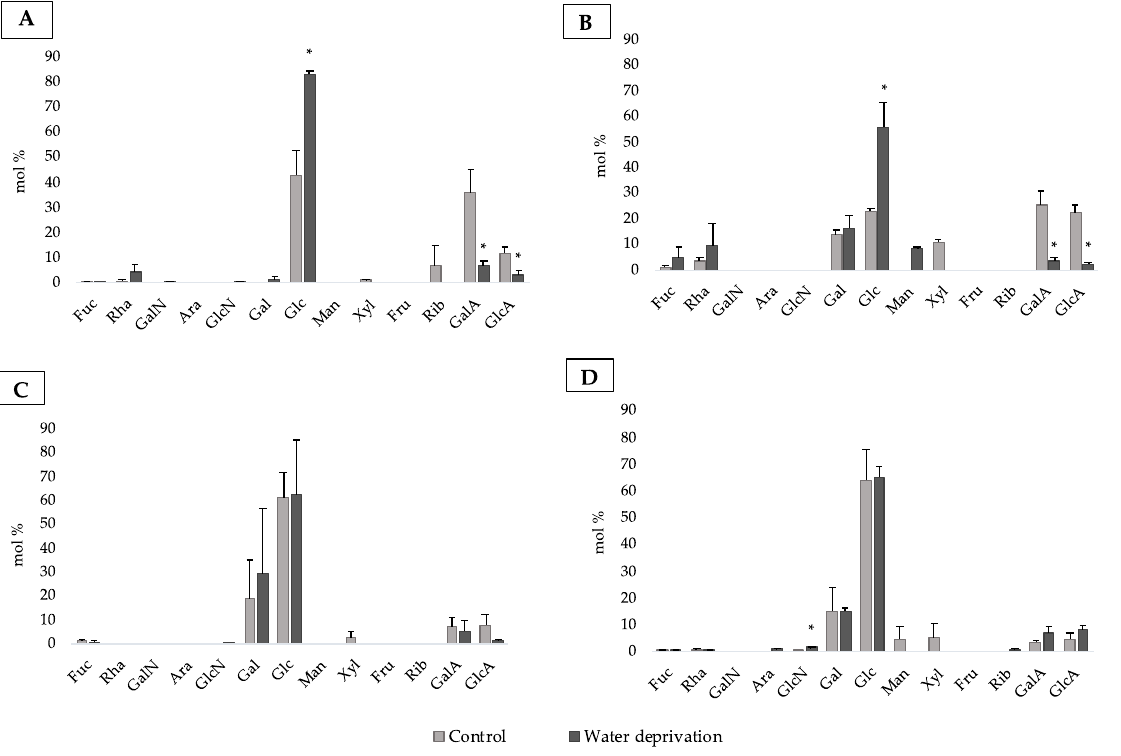
Figure 3. Monosaccharidic composition of the EPS extracted from biocrusts: ( A ) LB-EPS from P. ambiguum, ( B ) LB-EPS from L. ohadii , ( C ) TB-EPS from P. ambiguum , ( D ) TB-EPS from L. ohadii . Molar percentages (%) of single sugars are represented (expressed as moles of the single monosaccharide divided by the total amount of moles of monosaccharides in the EPS × 100). Symbol *, when present, indicates significant differences between the control and watered-deprived period in each mono- saccharide. Fuc, fucose; Rha, rhamnose; GalN, galactosamine; Ara, arabinose; GlcN, glucosamine; Gal, galactose; Glc, glucose; Man, mannose; Xyl, xylose; Fru, fructose; Rib, ribose; GalA, galacturonic acid; GlcA, glucuronic acid.